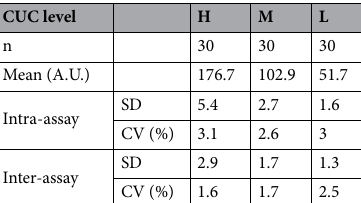
Table 1. Assay precision evaluation. H, M, and L indicate control pooled serum specimens with high, middle, and low CUC, respectively. A.U. arbitrary units, SD standard deviation, CV coefficient of variation.